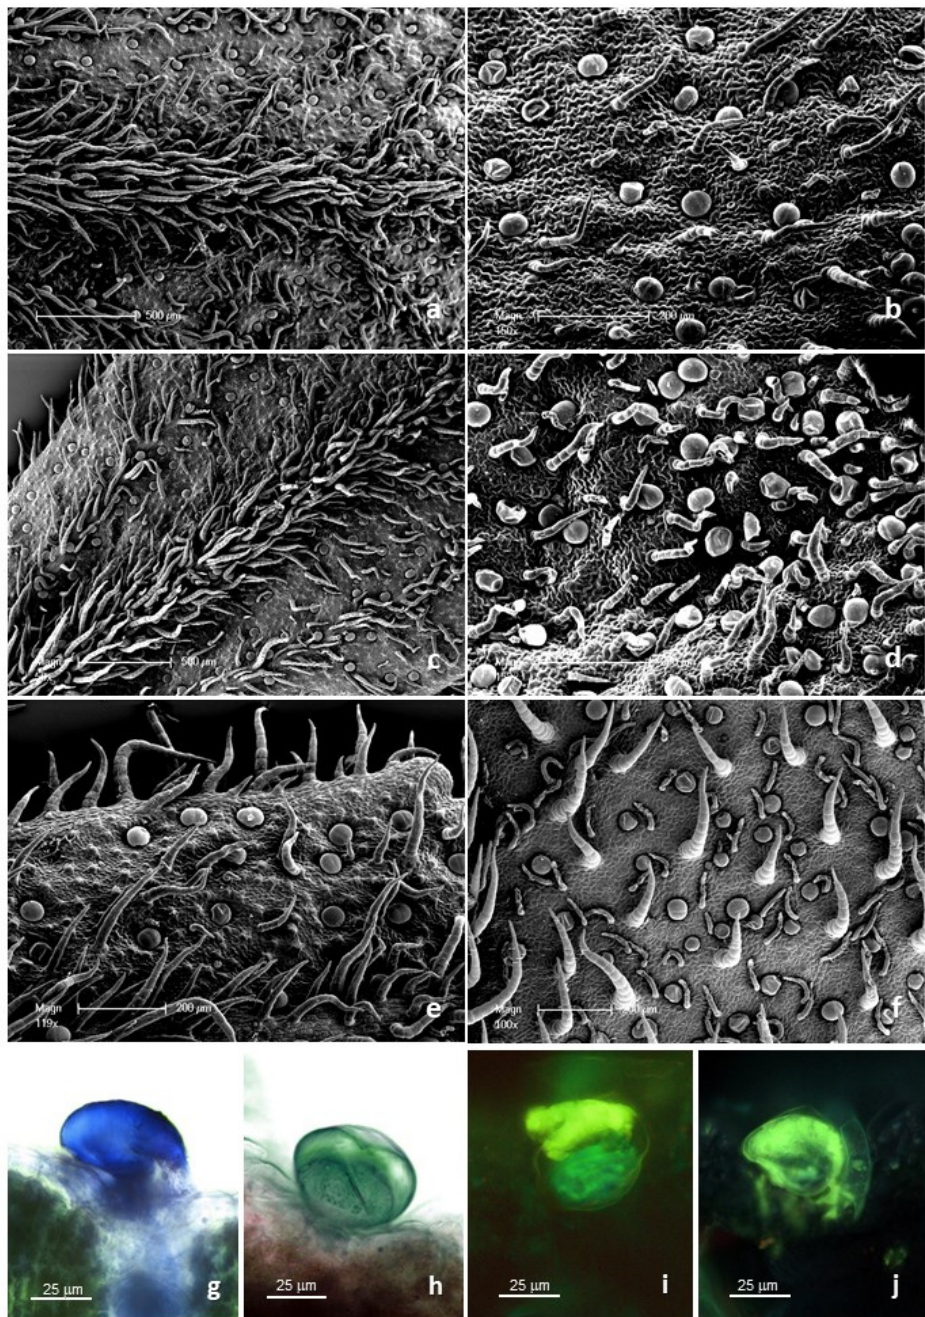
Figure 2 . ( a – f ) SEM micrographs showing the distribution pattern of the covering and glandular trichomes on the leaves of the examined specimens of Stevia rebaudiana . ( a , b ) Details of the abaxial ( a ) and adaxial ( b ) leaf surfaces of the underwater-grown samples (hydroponic). ( c , d ) Details of the abaxial ( c ) and adaxial ( d ) leaf surfaces of the underwater-grown samples (pot). ( e , f ) Details of the abaxial ( e ) and adaxial ( f ) leaf surfaces of the terrestrial samples (pot). ( g – j ) LM and FM micrographs showing the histochemistry of the glandular trichomes on the leaves of the examined specimens of Stevia rebaudiana . ( g ) Nadi reagent. ( h ) Ferric Trichloride. ( i ) Naturstoff reagent A. ( j ) Aluminum Trichloride.